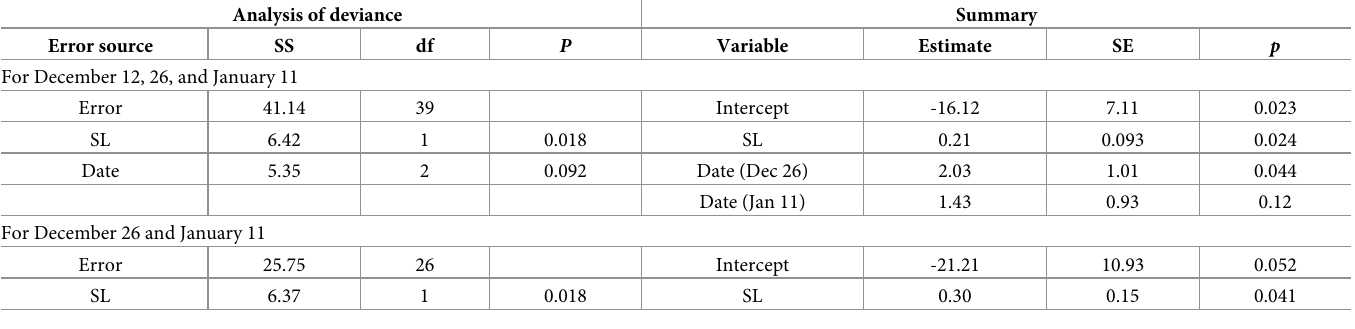
Table 3. Results of the generalized linear model for maturity (mature/immature) of western sand lance ( Ammodytes japonicus ) in low ration group in Experiment II.